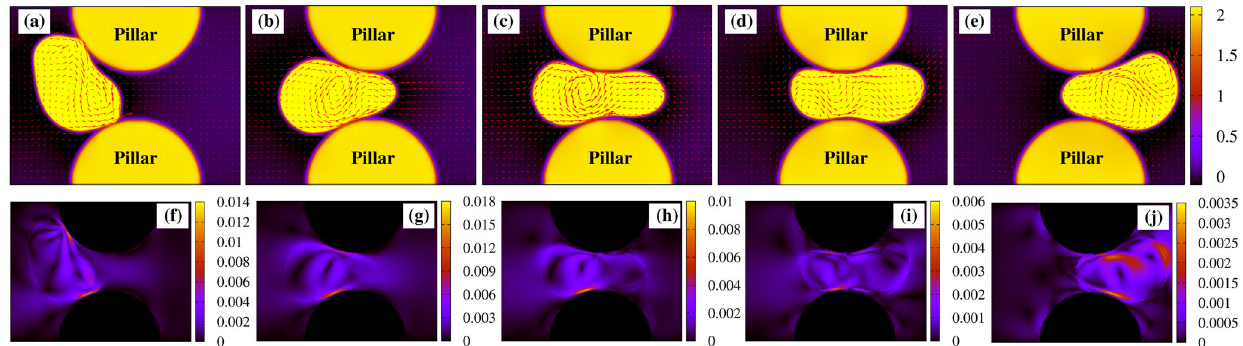
Fig. 4 | Velocity fi eld in a medium size constriction. The top row a – e shows the structure of the velocity fi eld v within and in the surrounding of an active droplet crossingaconstrictionwhere λ ≃ 0.5,whilethebottomoneshowsitsmagnitude ∣ v ∣ . The double vortex pattern observed in the unconstrained motile droplet (see Fig.1g)turnsintoasingleonerotatingcounterclockwise( a ),withmagnitudelarger nearthepillars( f ).Oncethedropletentersthepore,suchvortexshiftstowardsthe